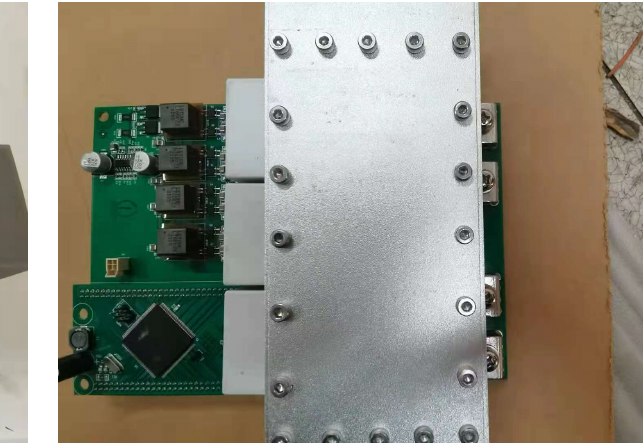
Figure 16. Capacitors and